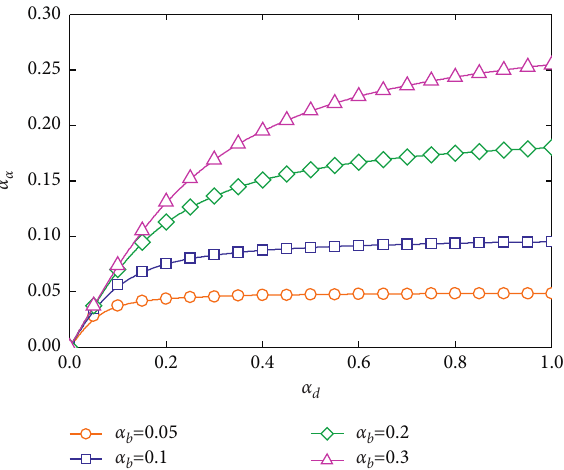
Figure 4: Variations of the stiffness ratio α under various α b .